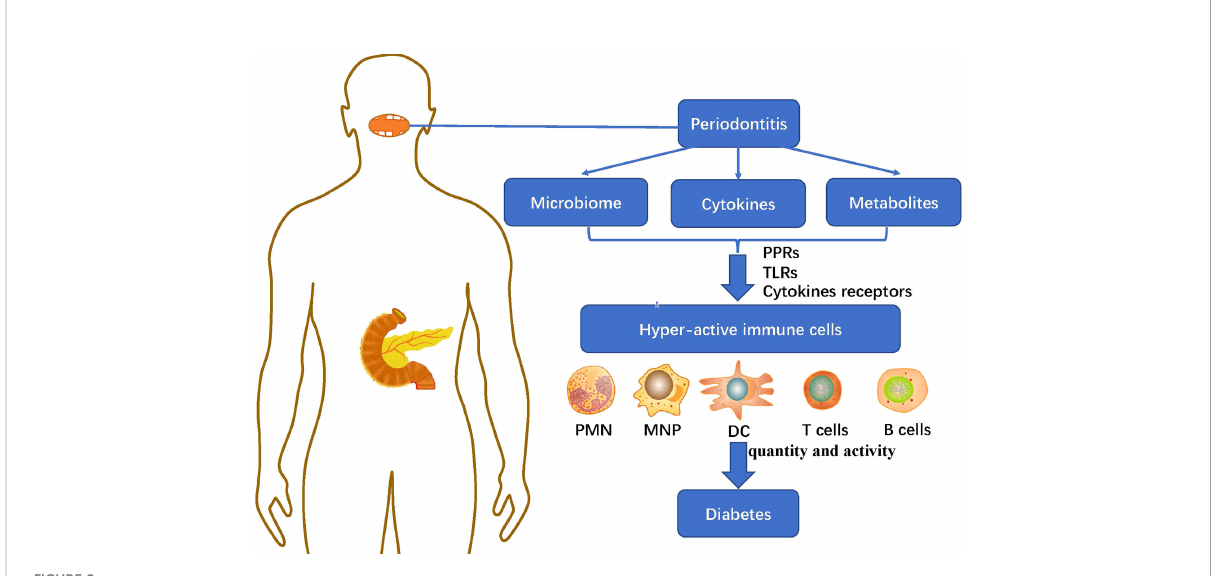
FIGURE 2 The immunoregulatory effect of periodontitis microbiome and metabolites on diabetes: The imbalance of periodontal microbiome and the accumulation of cytokines and metabolites in periodontitis mediate the recruitment, activation and differentiation of speci fi c immune cells including: PMN, MNP, DC, T cells and B cells, through PRRs, TLRs and cytokines receptors, causing long-term low-grade in fl ammatory state of the host and promoting the progress of diabetes. PMN, polymorphonuclear neutrophil; MNP, mononuclear phagocytic cells; DC, dendritic cells; PRRs, pattern recognition receptors; TLRs, Toll-like